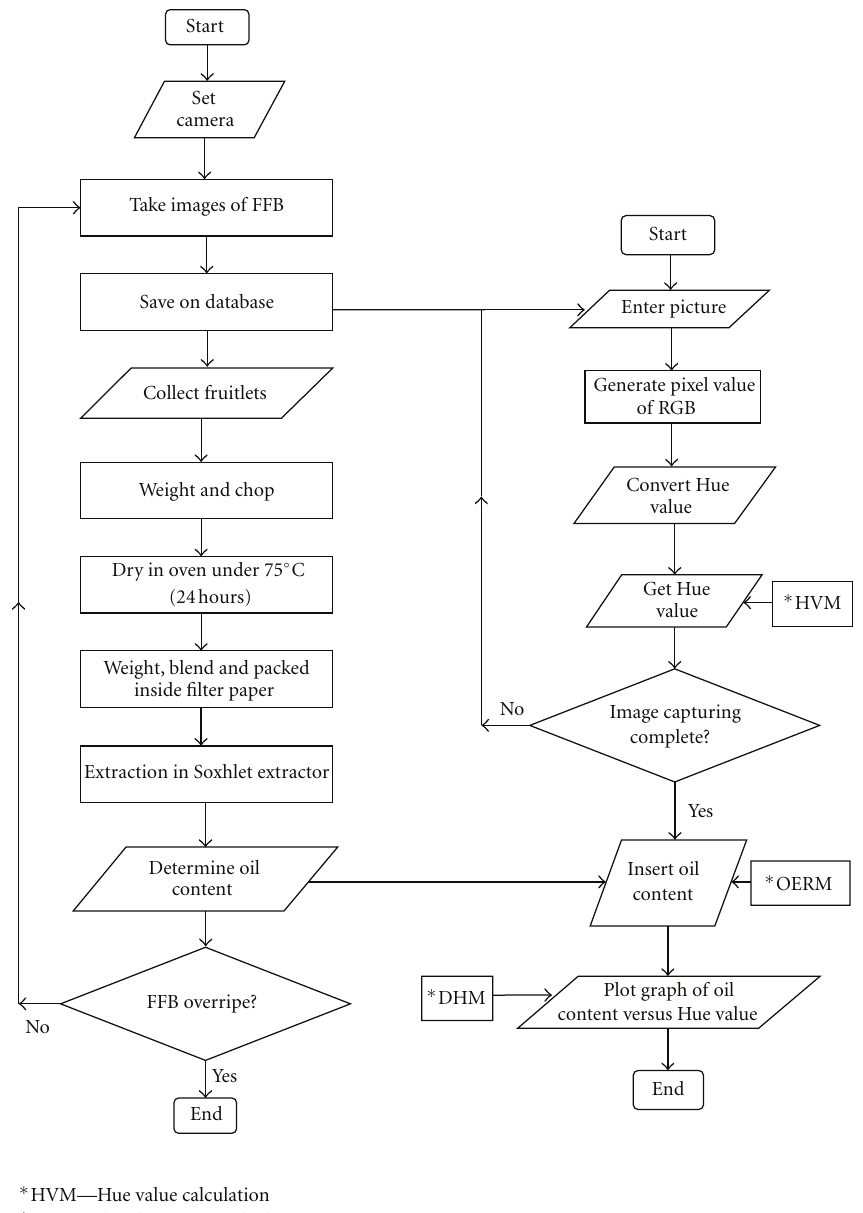
Figure 1: Flow chart of the involved